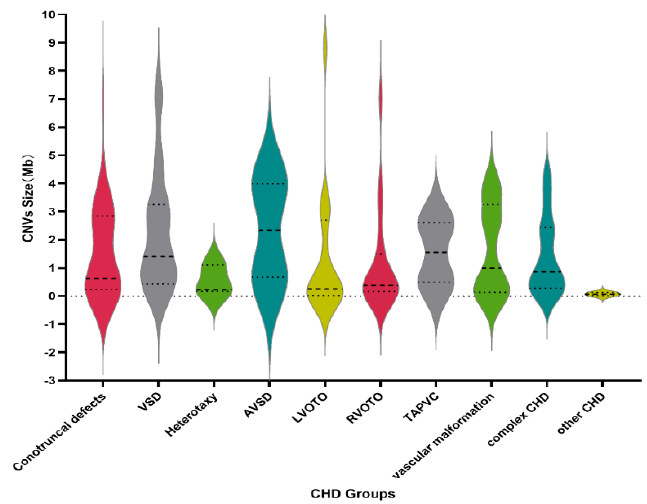
Figure 2. Violin plots show the distribution of the total CNV length in each group of fetal CHDs. The distribution of the lengths of all CNVs of fetuses with CHDs is represented in the figure. The thickened dotted lines indicate the median, the dotted lines represent the first and third quartiles, and the vertices of each violin plot represent outside points. VSD: ventricular septal defect; AVSD: atrioventricular septal defect; LVOTO: left ventricular out fl ow tract obstruction; RVOTO: right ventricular out fl ow tract obstruction; TAPVC: total anomalous pulmonary venous connection.